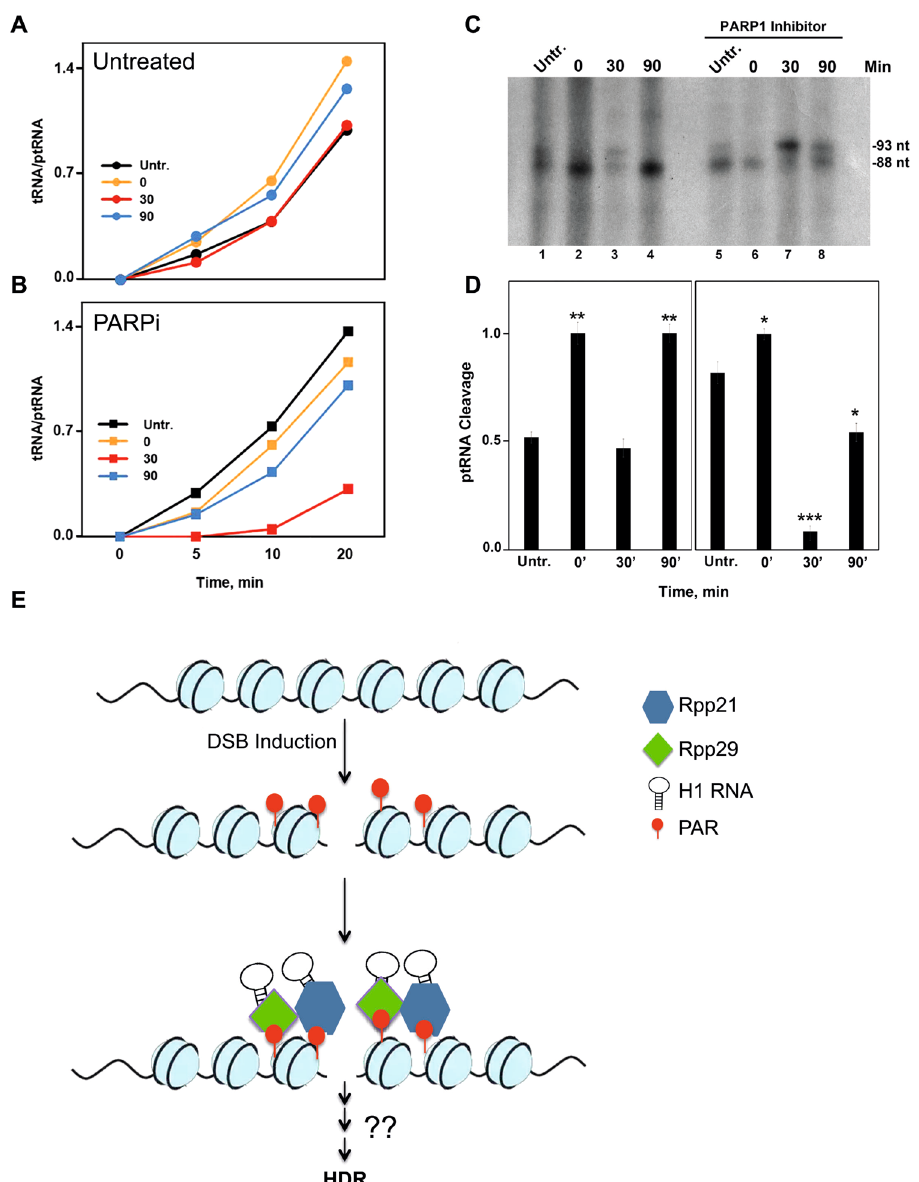
Figure 8. RNase P activity is induced after DNA damage in a PARP1-dependent manner. Whole cell extracts were prepared from untreated ( A ) and PARPi treated cells ( B ), and mature tRNA and ptRNA bands, seen in Supplementary Fig. S10, were quantified and ratios of product/substrate were plotted. ( C ) Processing of a nascent precursor tRNA Arg (UCU) is inhibited by PARP1 inhibitor. U2OS cells were treated as in Supplementary Fig. S10, and dialyzed S20 extracts were assayed for processing of nascent precursor tRNA Arg transcribed from a cloned gene for the indicated times (in min), as previously described 50 . Labeled RNAs were resolved in an 8% polyacrylamide sequencing gel. The positions of the primary transcript, 93 nt in length, and transcript processed at 5 ′ end by RNase P, 88 nt in size, are shown. Extracts of U2OS cells are not as efficient as HeLa cells in tRNA gene transcription and splicing to mature tRNA (not shown), thus producing weak labeled RNA signals. ( D ) The 93- and 88-nt transcript bands seen in C were quantitated and the ratios of processed to unprocessed tRNA Arg were plotted. P-values were calculated by two-sided Student’s t-test relative to scr shRNA; * , ** , and *** indicates significance of p < 0.05, 0.01 and 0.001, respectively. (E) A hypothetical model shows that local ADP-ribosylation at DSB site and H1 RNA molecule underpin the recruitment of Rpp29 and Rpp21 to promote HDR of